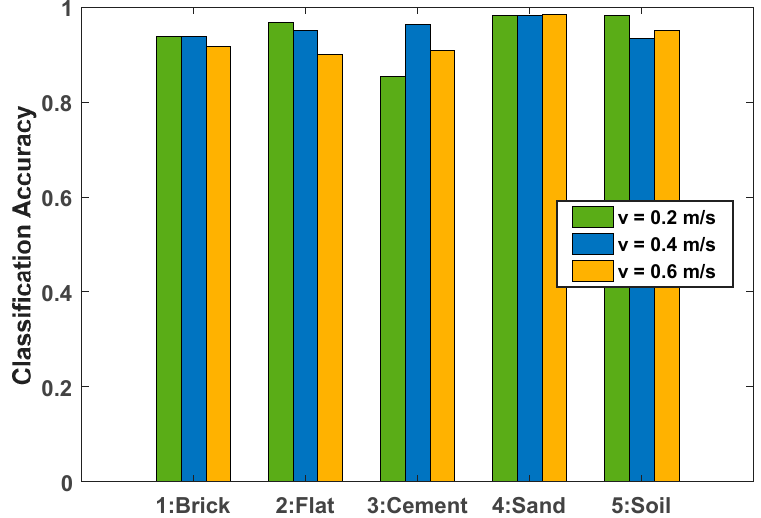
Figure 12. Classification accuracy based on the XQ platform at different speeds.